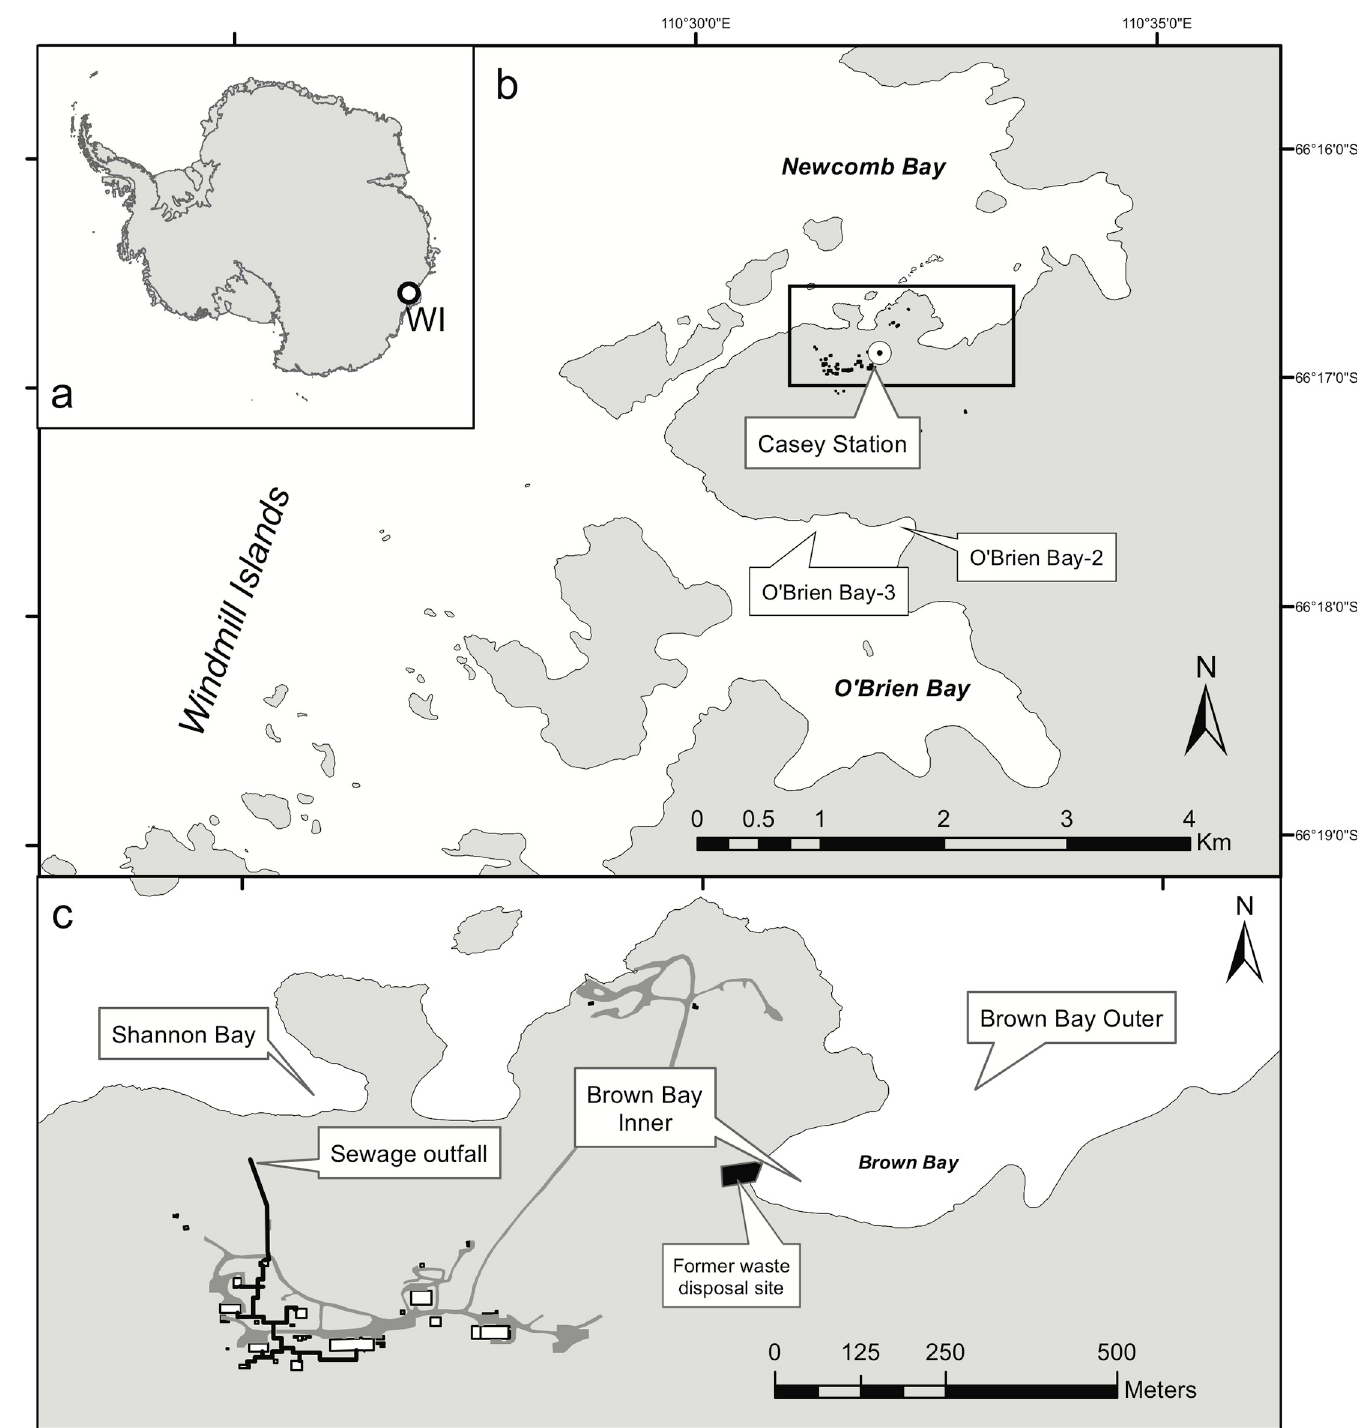
Fig 1. Location of study site. a) Location of Windmill Islands (WI) in East Antarctica; b) the Windmill Islands area around Newcomb and O’Brien Bays showing the position of Casey station and sites in O’Brien Bay with inset c) Casey station, and Shannon and Brown Bays. The topographic data was obtained from the Australian Antarctic Data Centre (https://data.aad.gov.au/aadc/portal/drill_down.cfm?id=14) and used with permission under the Creative Commons Attribution 3.0 Unported License. The map was made with ArcGIS 10.4.